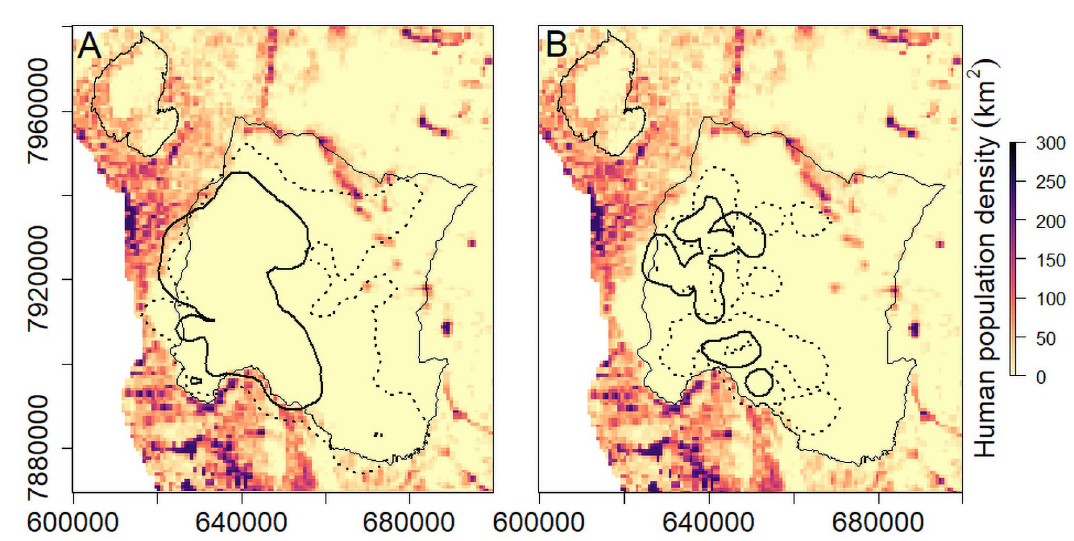
Fig 7. Territories of wild dogs (solid line) and lions (dotted line) in Gorongosa National Park between June 2018 and September 2020 for the (A) 95% total territory areas and (B) the 50% core territory areas. The boundary of GNP is shown as thin black line with the maps overlaid on that of human population density for the Gorongosa-Marromeu landscape.